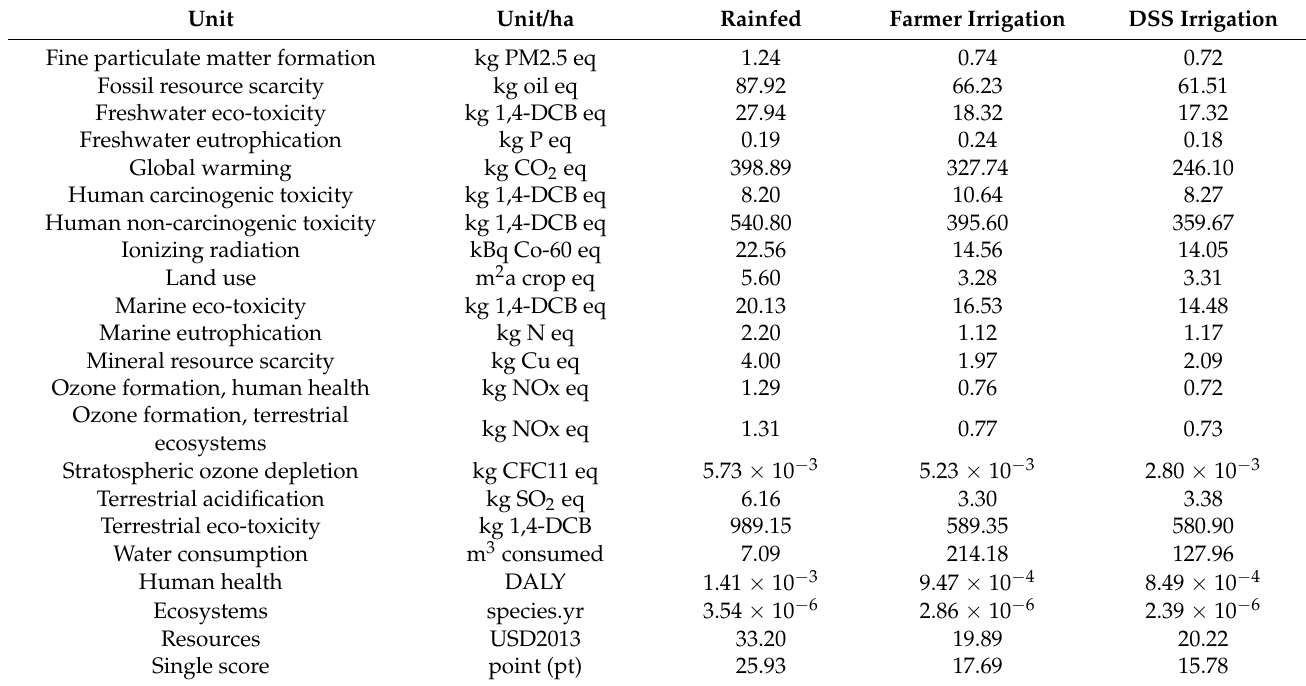
Table A5. LCA results with the ReCiPe 2016